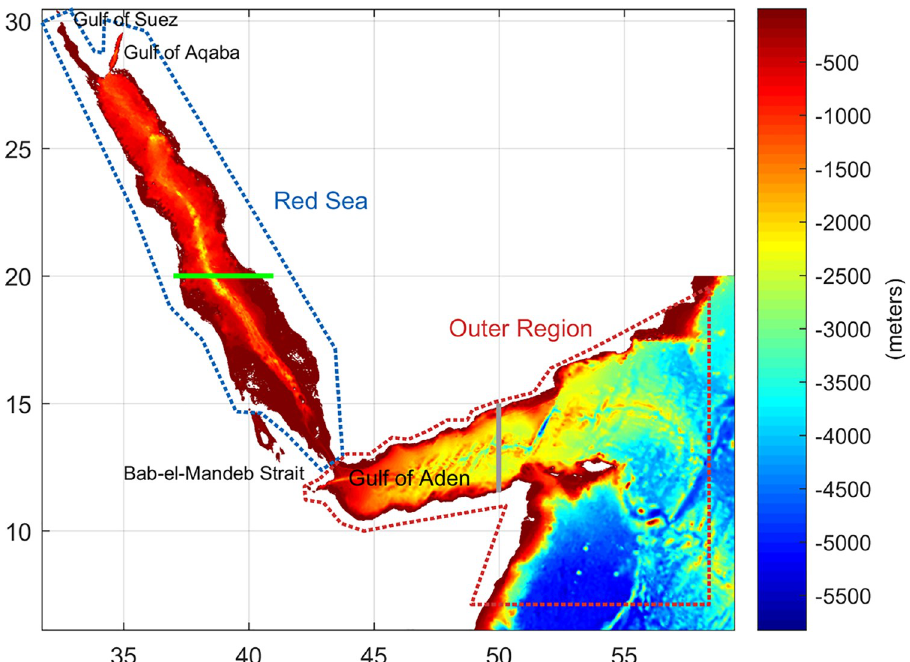
Fig 1. Domain and bathymetry of the region of interest. The two zones used in the presentation of the results (Red Sea and the Outer Region) are identified by blue and red dashed contours, respectively. Eastern boundary limit of the KAUST model (vertical grey line). Northern and Southern zones, as considered for the computations, are separated at latitude 20˚ (horizontal green line).